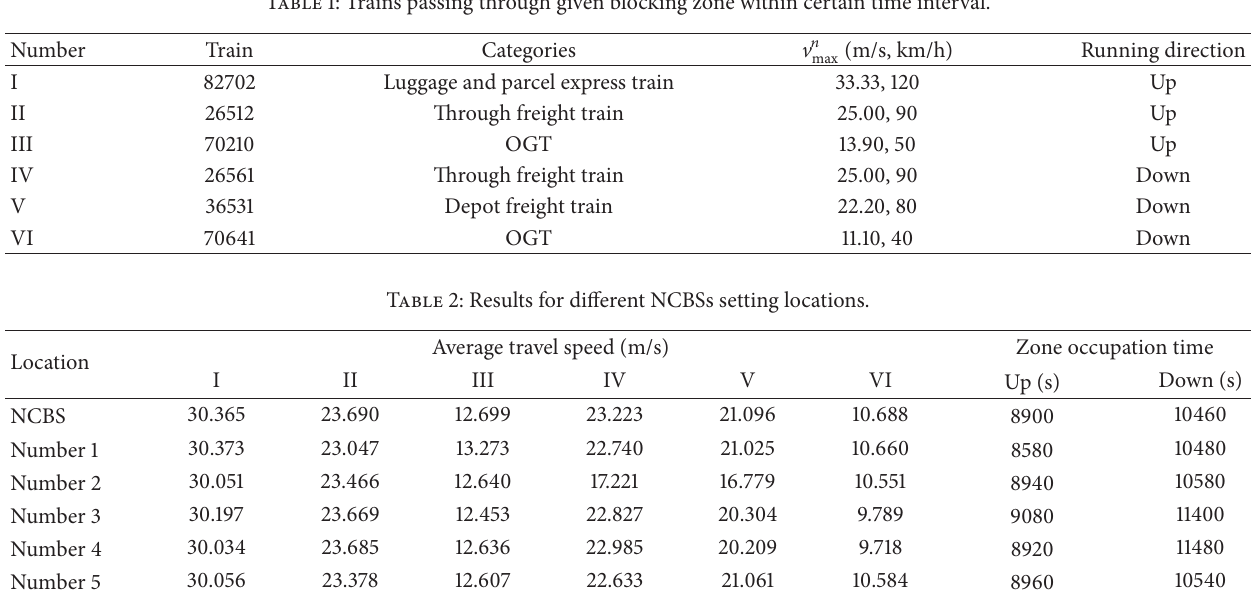
Table 1: Trains passing through given blocking zone within certain time interval.